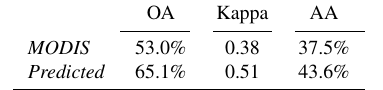
Table 4. Accuracy metrics of the LCCS maps for the Munich scene. The predicted result was achieved by patch classification based on a ResNet-110 CNN. The evaluation is based on manually labeled reference points.